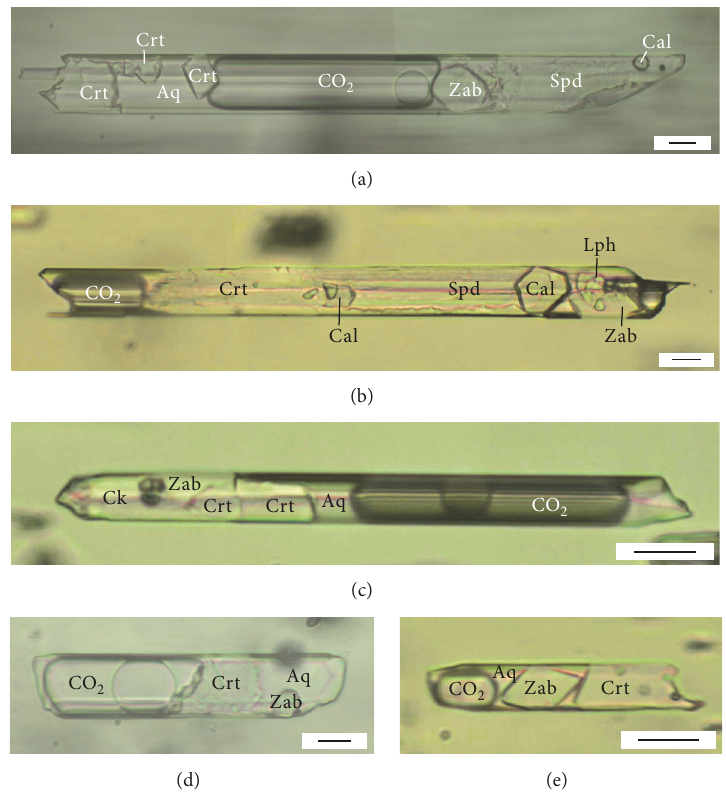
Figure 5: The crystal-rich inclusions hosted in spodumene from the Jiajika deposit. Crt- critobalite, Spd- spodumene, Zab-Zabuyelite, Cal- calcite, Qz- quartz, Ck- cookeite, Aq- aqueous fluid, CO 2 - CO 2 fluid. The length of the scale bar in black is 10 𝜇 m.